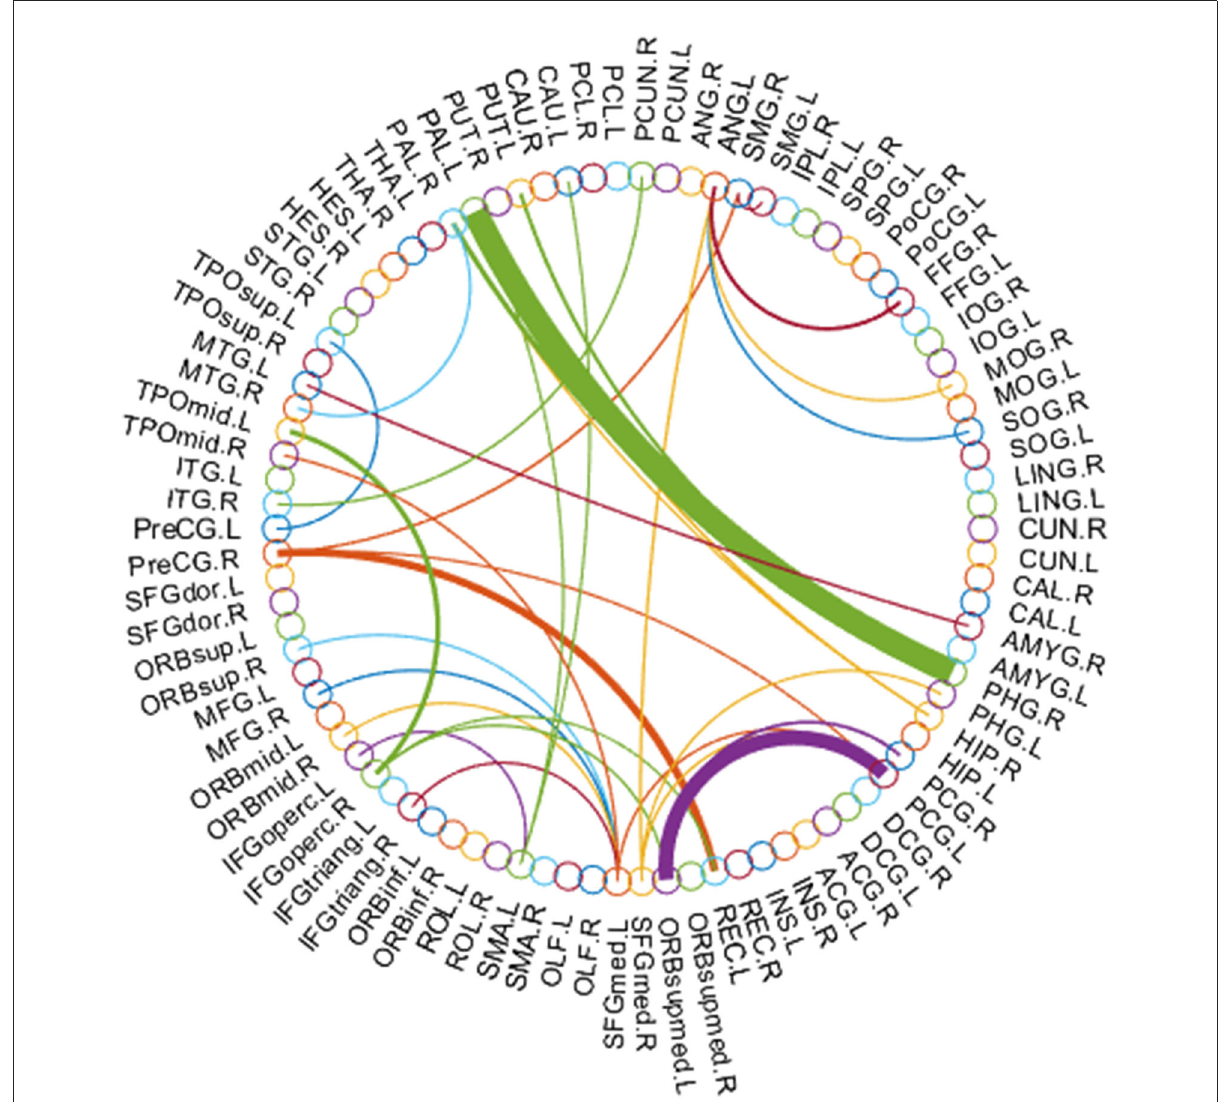
FIGURE5 Most discriminative connections between ASD and NC for the first 90 ROIs of the AAL